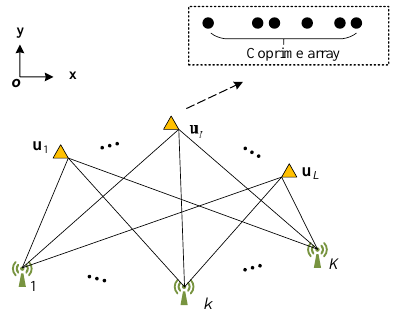
Figure 1. Localization geometry.